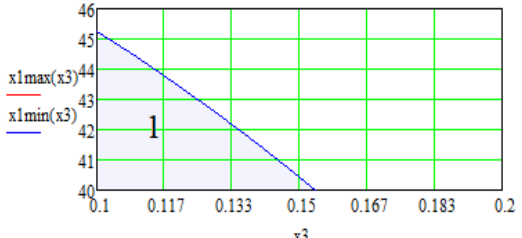
Fig. 5. Range of values of factors x1 and x2 to fulfil the condition 0.1≤y1≤0.11